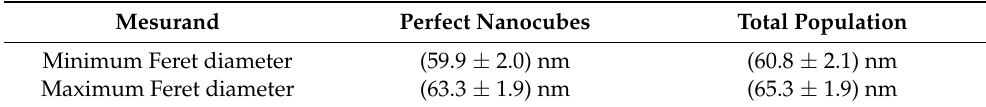
Table 8. SEM size measurements of the perfect nanocubes compared with the total population including the “badly” oriented and poorly formed particles.